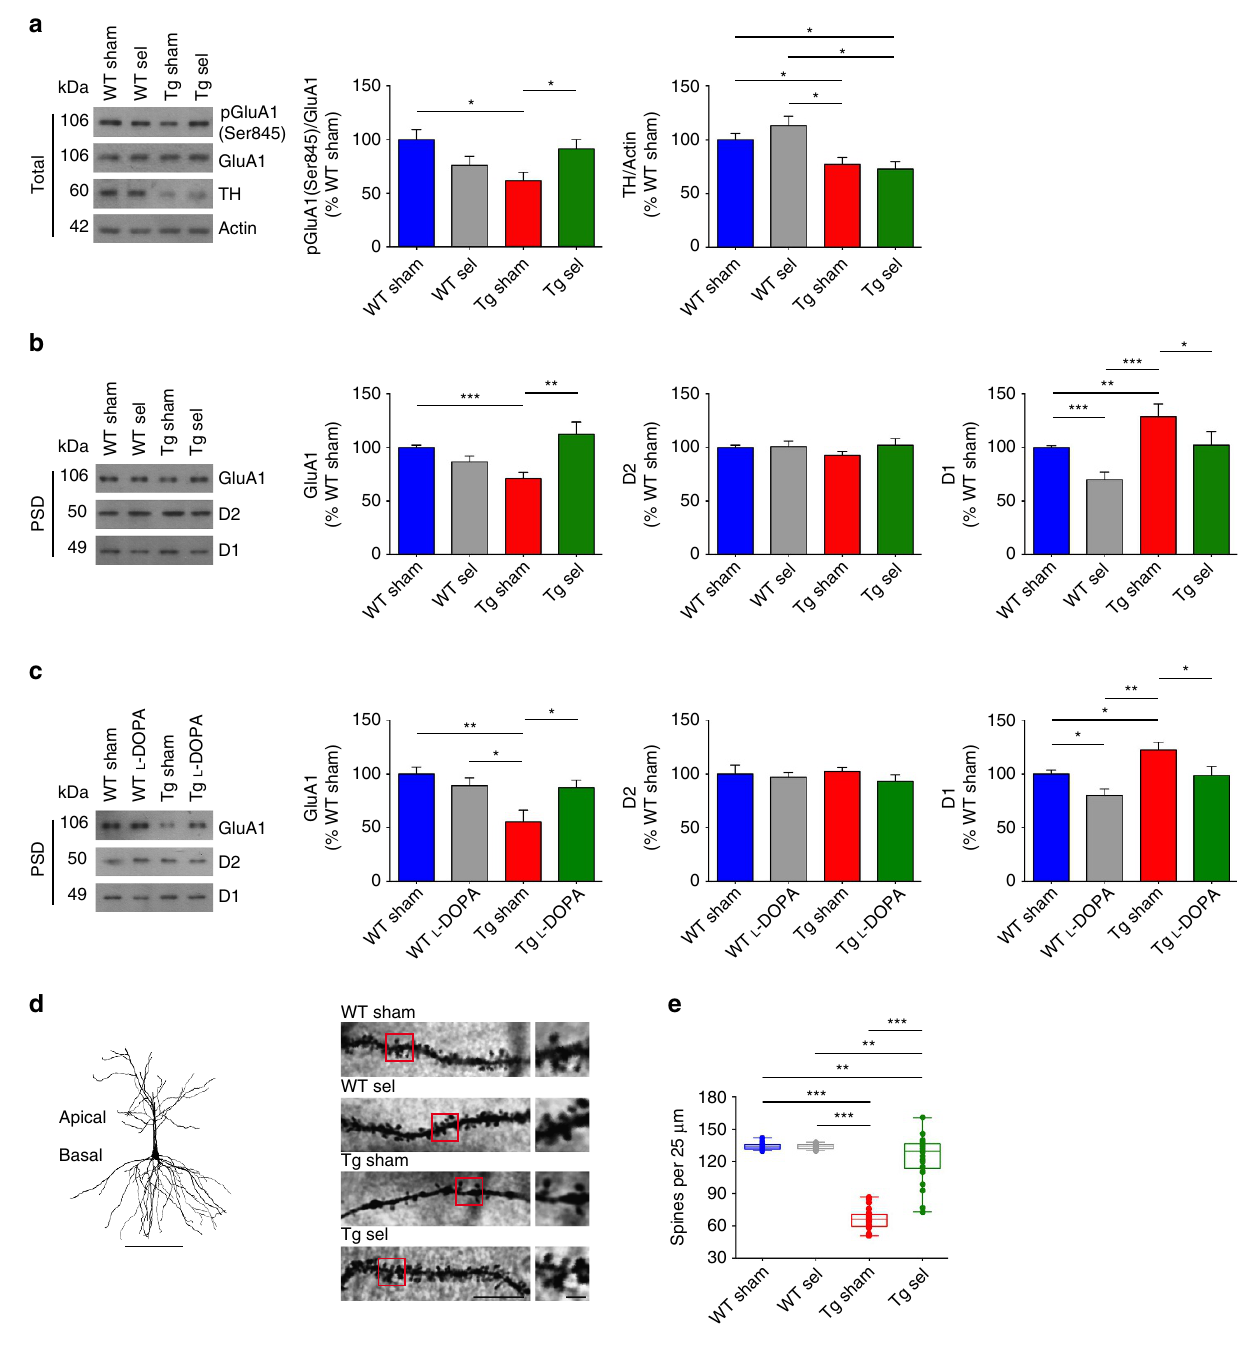
Figure 6 | Sub-chronic selegiline or L -DOPA treatment rescues hippocampal PSD composition and dendritic spine density in Tg2576 mice. ( a – c ) Representative immunoblots of total ( a ) and PSD ( b ) hippocampal proteins from 6-month-old WTand Tg2576 mice treated with selegiline (sel) or saline (sham) and PSD proteins ( c ) prepared from L -DOPA or saline-treated mice, probed with the indicated antibodies, and densitometric quantification of changes in grey values. For total proteins actin was used as loading control. Selegiline does not rescue TH protein levels but selegiline and L -DOPA restore PSD composition in Tg2576 mice ( a : 8 mice per group; two-tailed unpaired t -test for pGluA1/GluA1: WT sham-Tg sham * P ¼ 0.012, Tg sham-Tg sel * P ¼ 0.027; for TH/actin: WTsham-Tg sham * P ¼ 0.029, WTsham-Tg sel * P ¼ 0.022, WTsel-Tg sham * P ¼ 0.017, WTsel-Tg sel * P ¼ 0.015; ( b ) 10